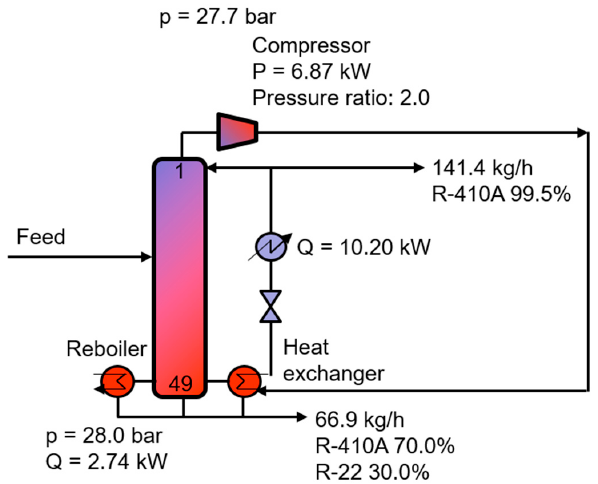
Figure 3. Simplified flowchart illustrating the MVR heat-pump-assisted conventional column.